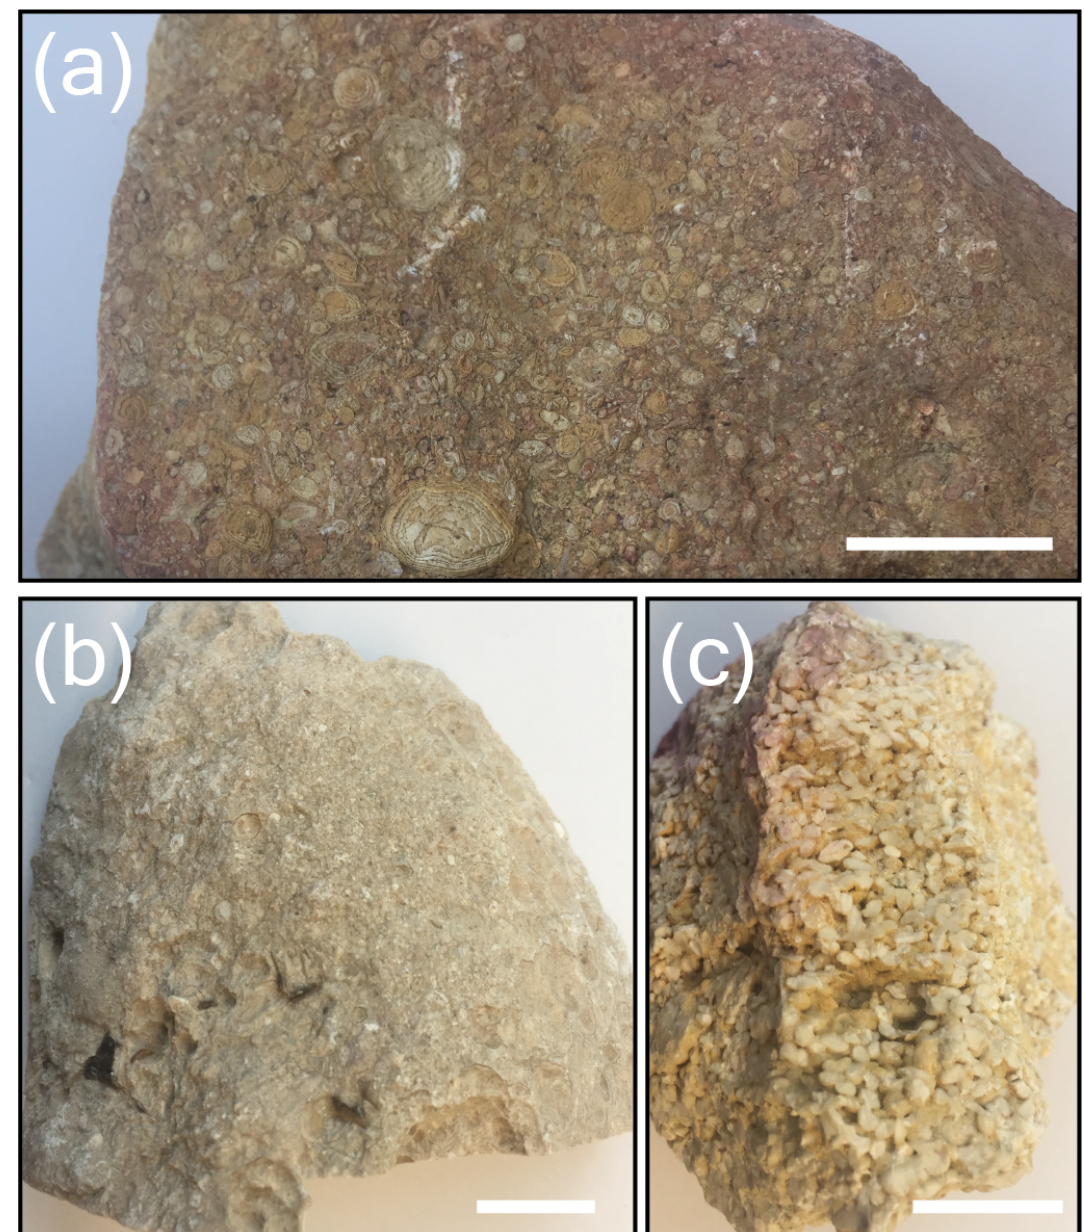
Figure 2. Hand specimen images of three samples. These show the range of fossiliferous carbonate sediments that were tested with the three disaggregation methods: (a) LF packstone–grainstone (sample K16), (b) bioclastic wackestone (sample JB1) and (c) LF packstone (sample L05). Scale bars are